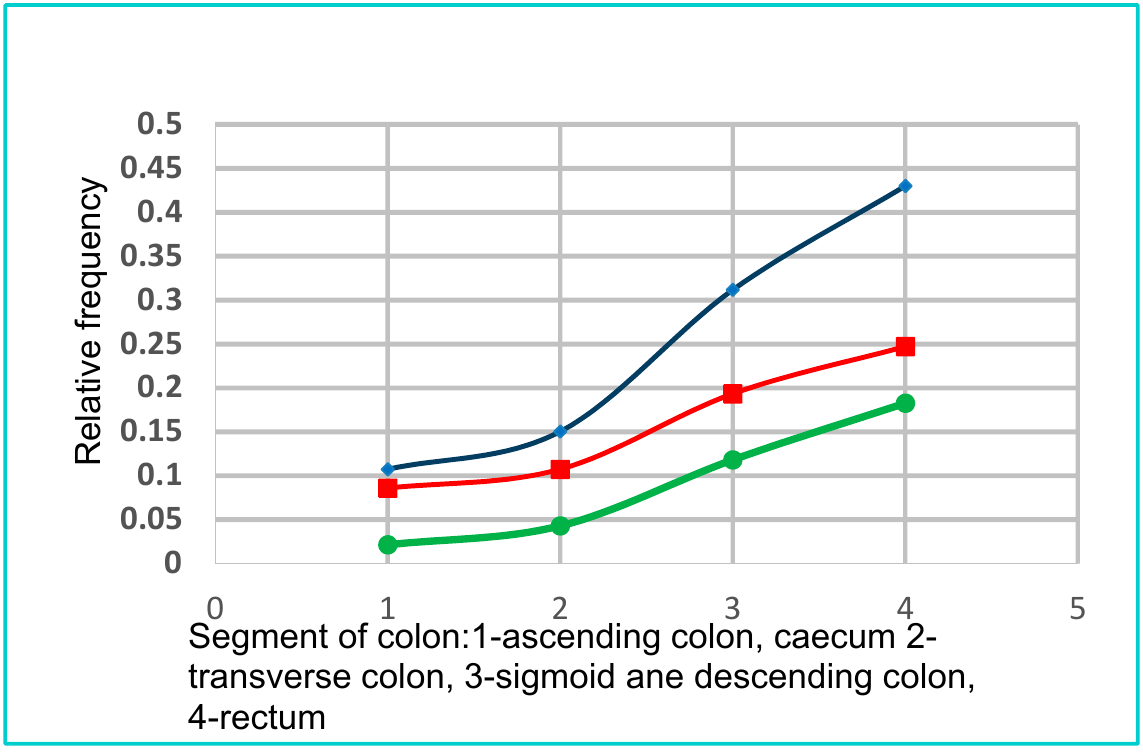
Figure 7. The presence of polyps in the study group in different sections of the colon. Green line: non ‐ smokers; red line: smokers; blue line: cumulative curve.